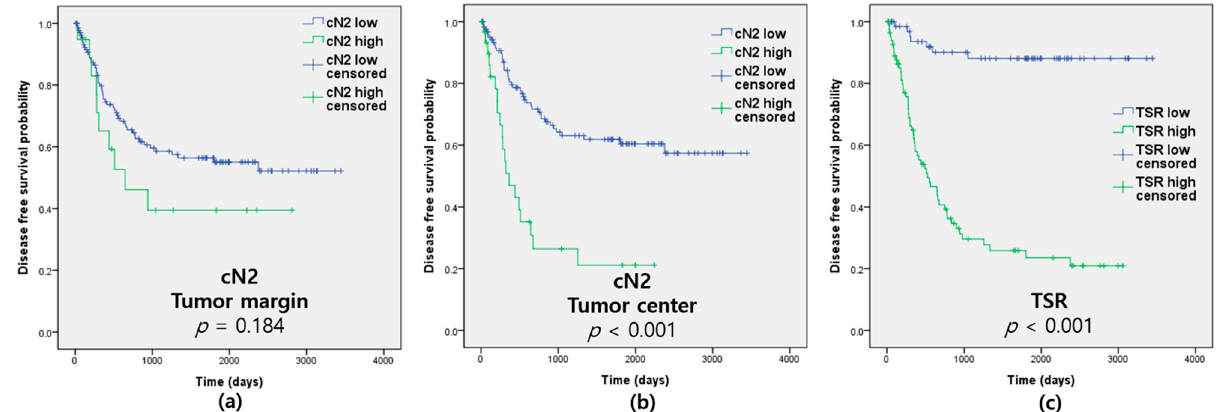
Figure 2 and Table 1). pTNM stage, lymphatic, venous and perineural invasion, tumor size, and neutrophils detected by CD15 were also significantly associated with prognosis